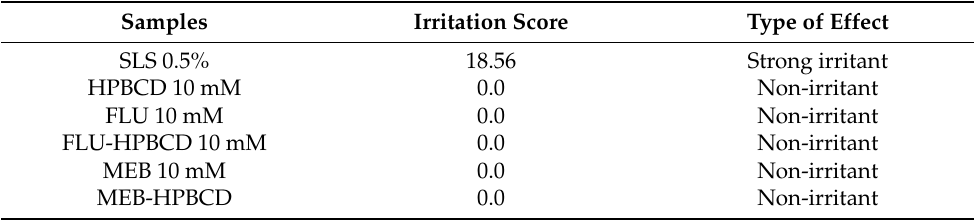
Table 3. The irritant potential of MEB, FLU, and their HPBCD